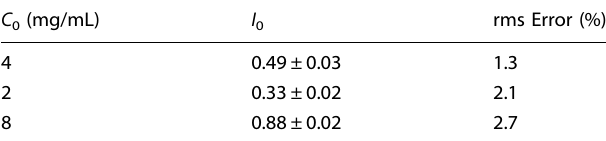
Table 1. Sigmoidal fi t (Eq. 1) parameters of native intensity ( I 0 ) and normalized fi t root-means-square (rms) error.